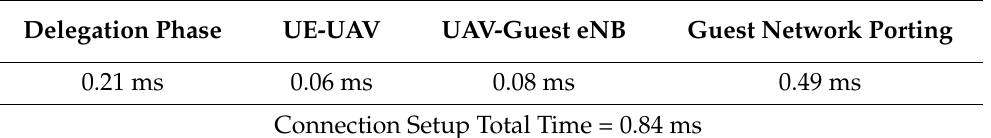
Table 2. Authenticated Inter-Operator Connection